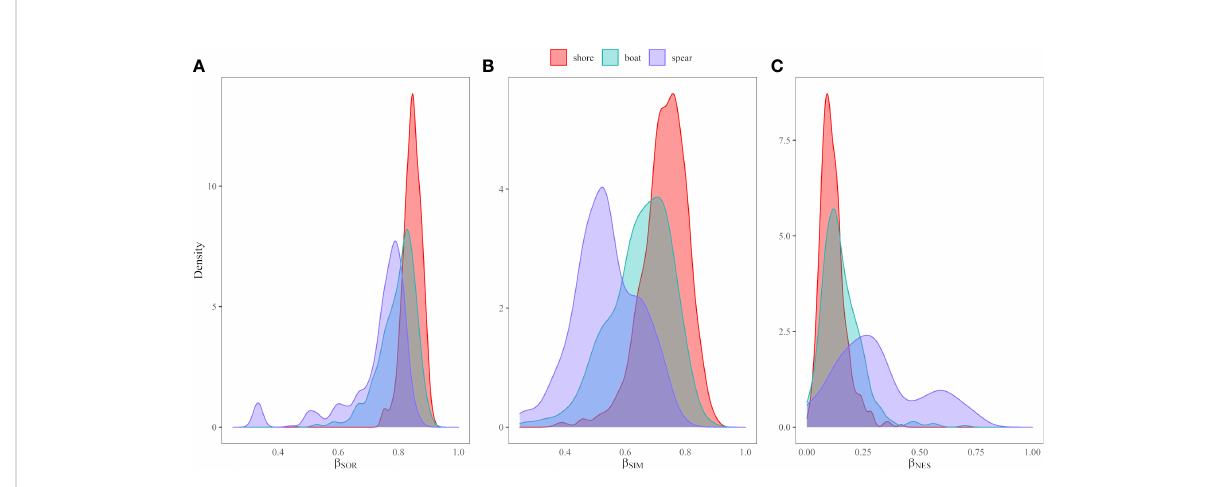
FIGURE 7 The partition of beta-diversity transformed as (A) Sørensen dissimilarity index ( b SOR ), and the partition in the (B) turnover ( b SIM ) and (C) nestedness ( b NES ) components, for shore fi shing (red), boat fi shing (light green) and spear fi shing